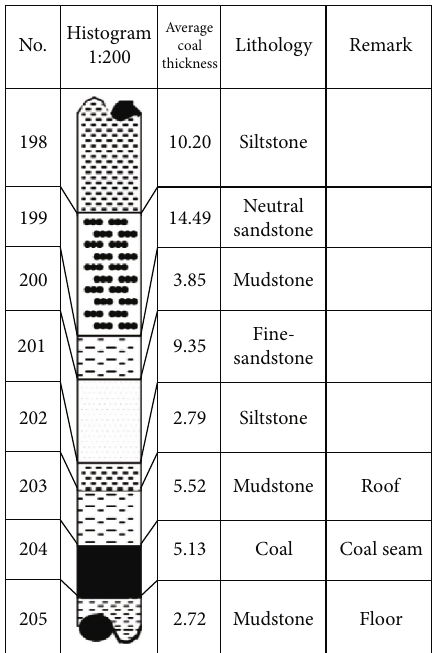
Figure 1: Comprehensive histogram of roof and fl oor slate of coal seam in 12070 working